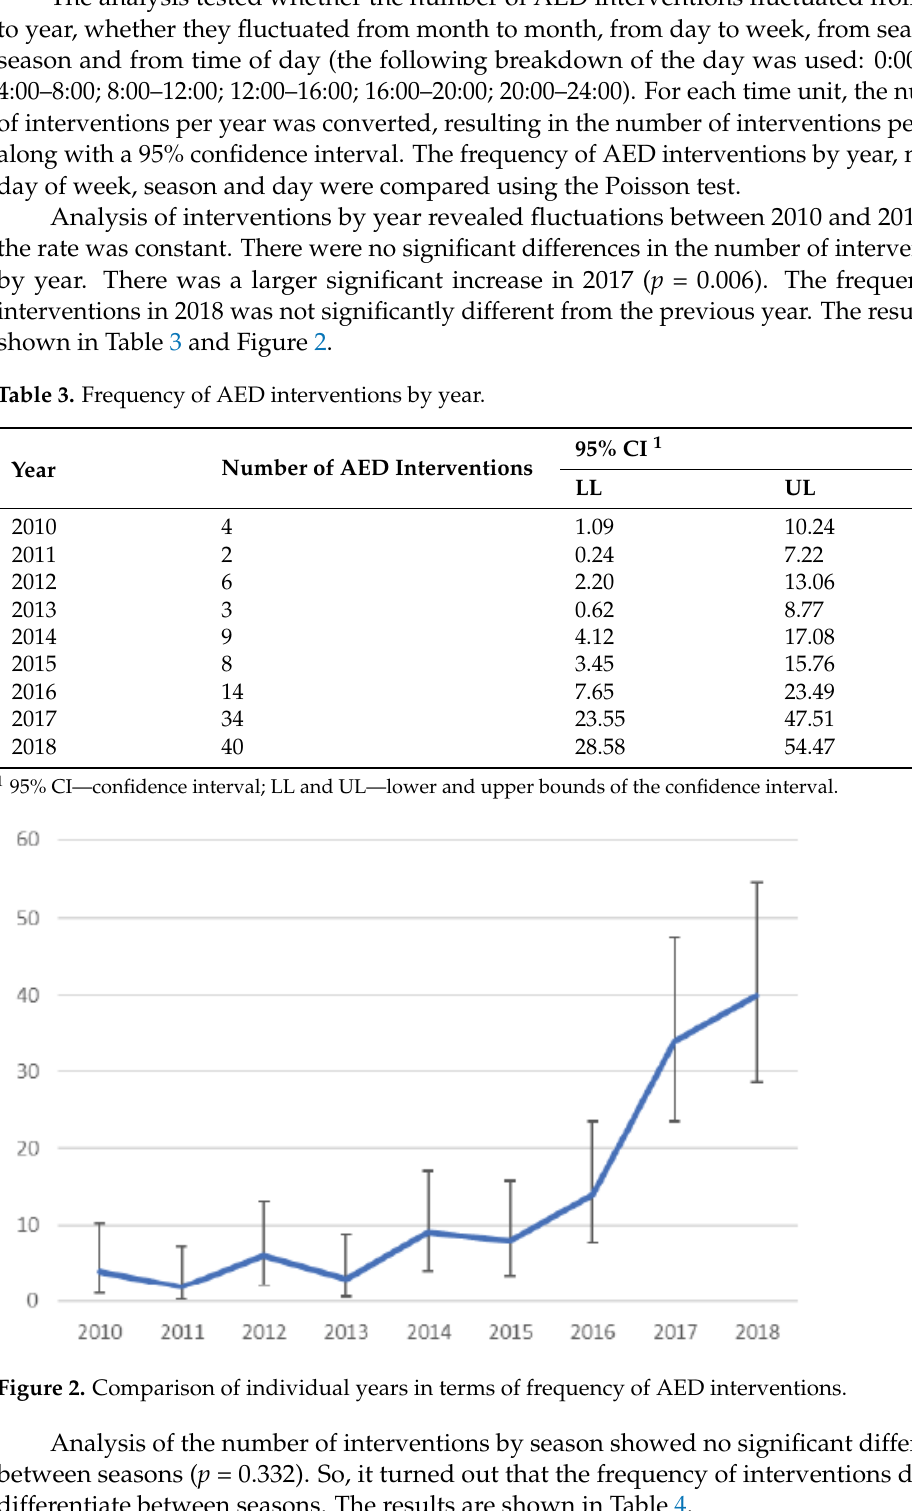
Table 3. Frequency of AED interventions by year.